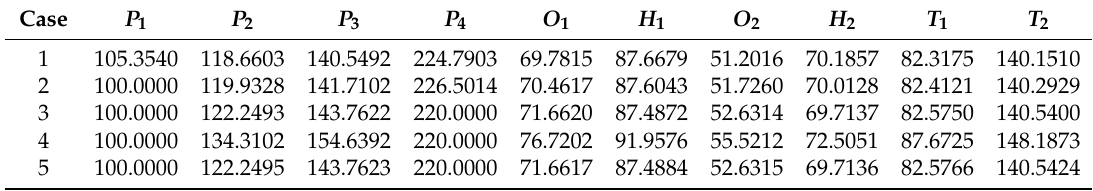
Table 1. The optimal outputs of different